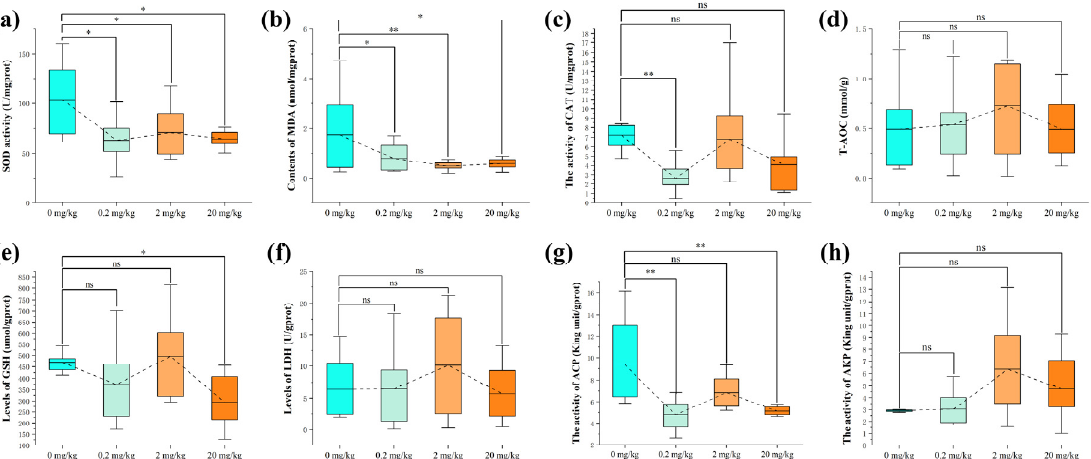
Figure 3. Changes in biochemical indices in the intestine of C. carpio fed by KM treatment: ( a ) SOD activities; ( b ) MDA levels; ( c ) CAT levels; ( d ) total antioxidant activity (T-AOC) levels; ( e ) GSH levels; ( f ) lactate dehydrogenase (LDH) levels; ( g ) alkaline phosphatase (ACP) activities; ( h ) AKP activities (data = mean ± standard error, n = 9). Asterisks denote that correlations were significant at p < 0.05 (*) and p < 0.01 (**) and “ns” denotes that correlations were no significant. 2.4. Transcriptome Sequencing and Verification We conducted transcriptome analyses of triplicate samples of each group and 94.85 GB of clean data were obtained and reached >6.94 GB per sample with errors < 0.025%. The clean reads that we obtained ranged from 47,470,704 to 62,952,880 and the average